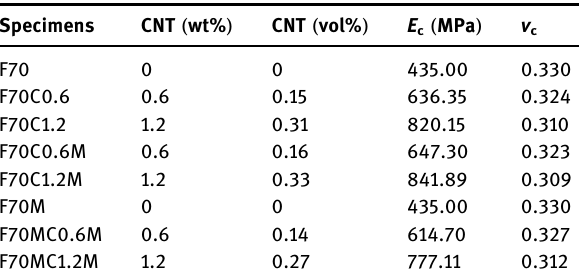
Table 6: Young ’ s modulus E c and Poisson ’ s ratio ν c for CNT - epoxy composite unit cells